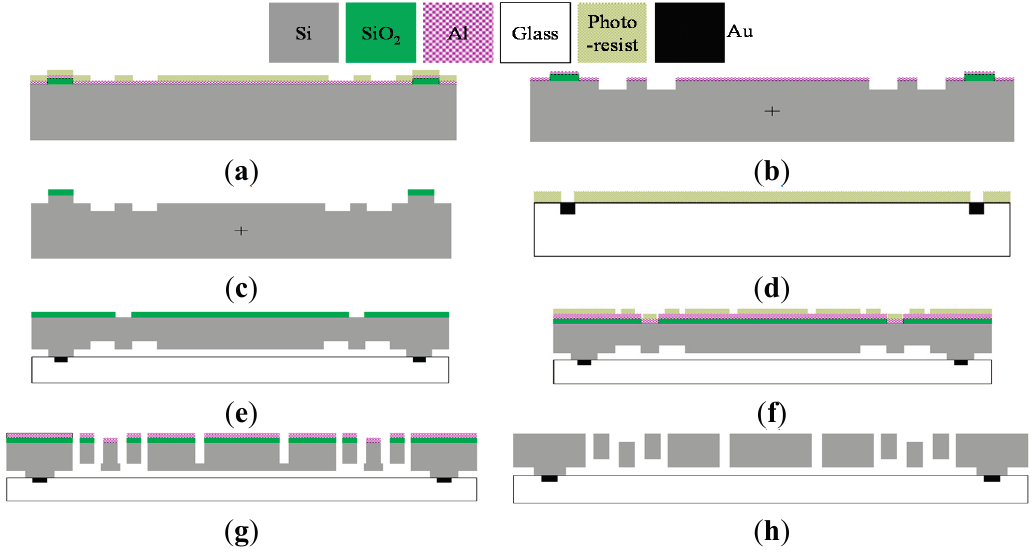
Figure 9. Fabrication process of the gyroscope. ( a ) Grow SiO 2 by PECVD and Pattern Al lift-off; ( b ) Etch bottom trench by ICP; ( c ) Form anchor by ICP; ( d ) Etch Ti/Au by BOE and lift-off; ( e ) Define Upper trench by PECVD of SiO 2 ; ( f ) Sputter Al by lift-off; ( g ) Release structure by ICP; ( h ) Etch upper trench by